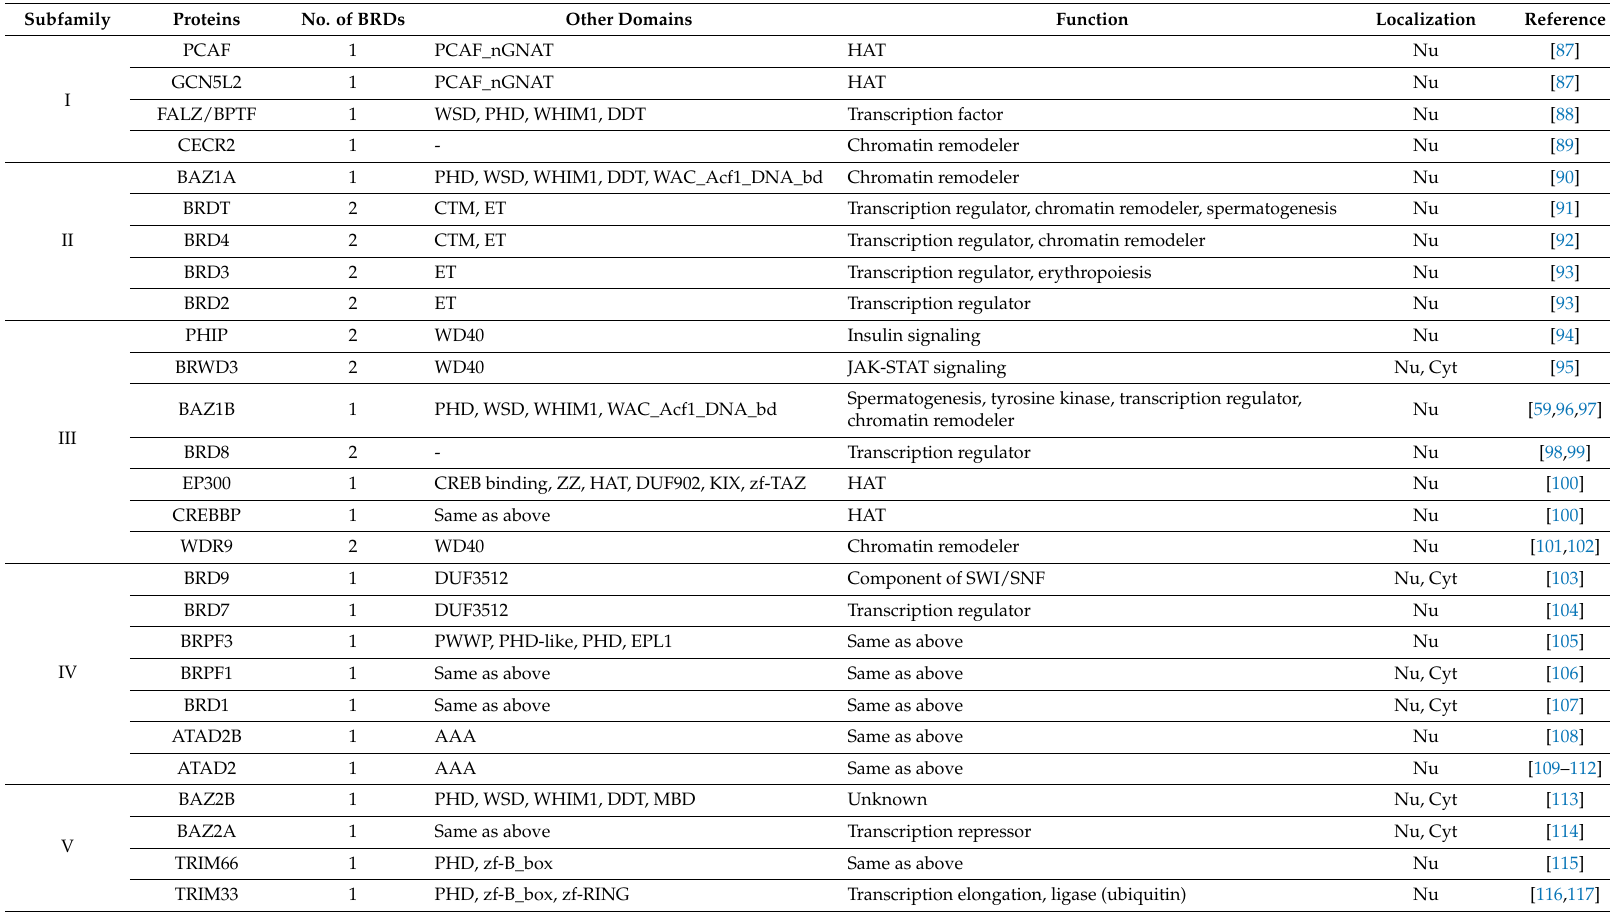
Table 3. Bromodomain family members and their